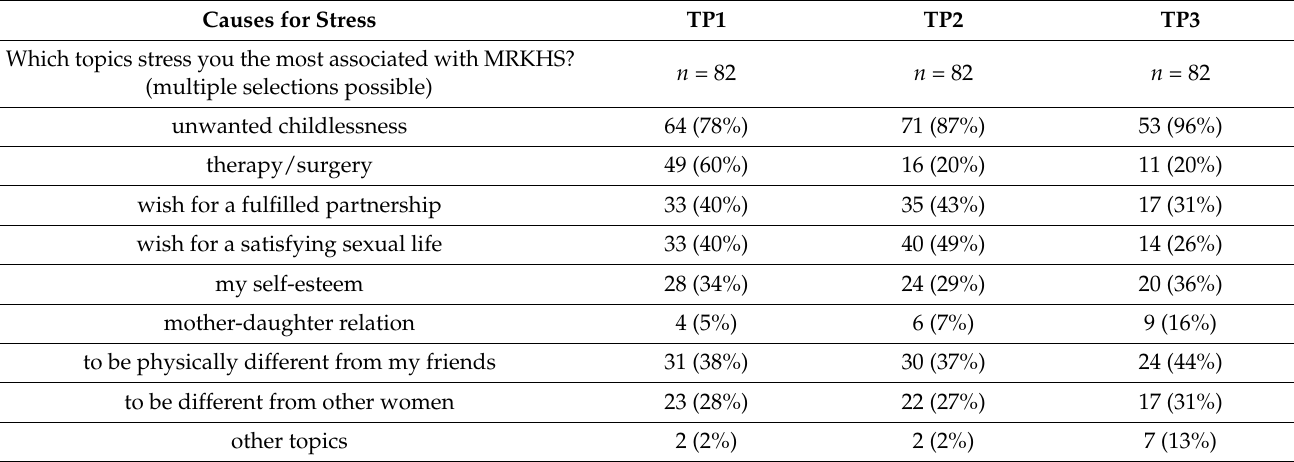
Table 4. Causes for stress associated with the MRKHS